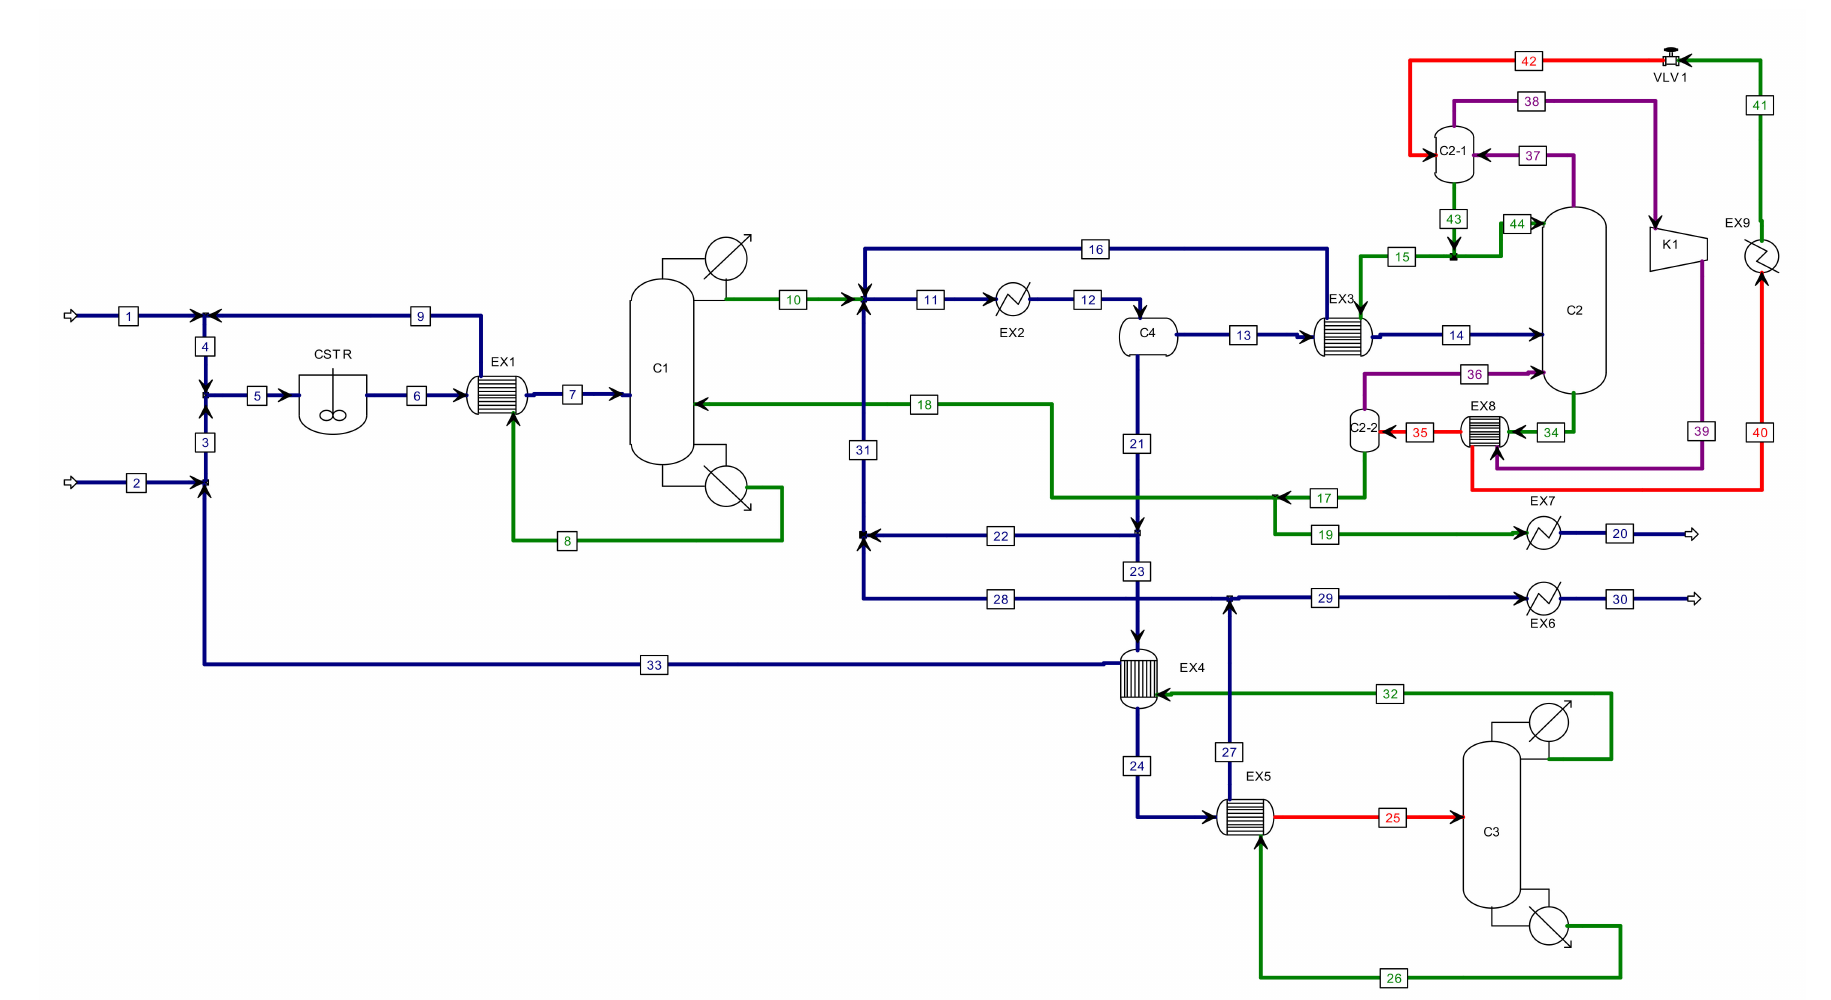
Figure 4. Ethyl acetate production via conventional process set-up with an MVRHP. Stream condition: blue—subcooled liquid; green—liquid at boiling temperature; red—vapor- liquid mixture; purple—saturated/overheated vapor. C1—azeotropic distillation column; C2, C3—distillation columns; C2-1,2—flash separators; C4—decanter; K1—compressor; CSTR—continuous stirred tank reactor; EX1-9—heat exchangers; VLV1—throttle